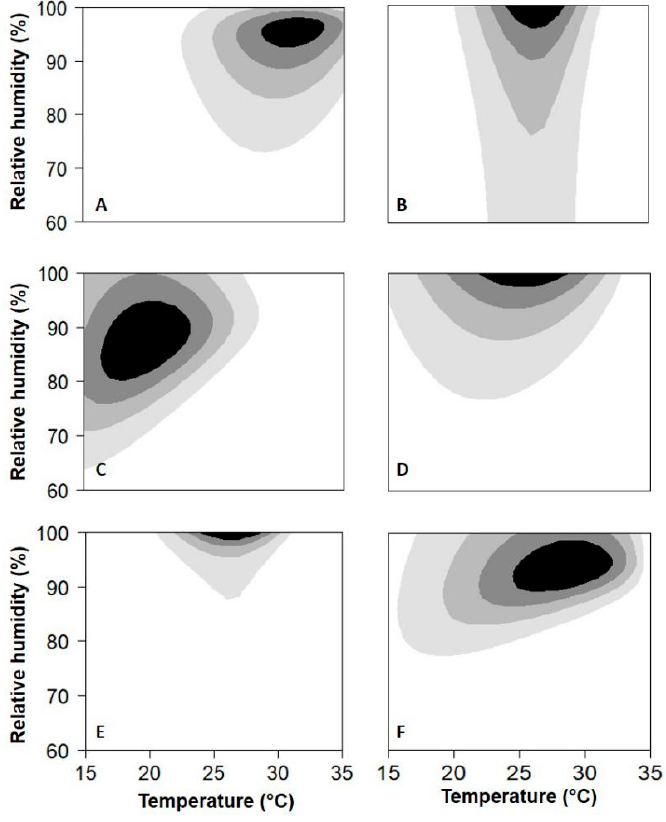
Figure 4. Relative colonization of bunch trash that was treated with one of six BCAs ( A : AMY; B : BOT; C : NOL; D : SER; E : TAE; F : VIN, see Table 1) and that was then incubated at different temperatures (T) and with different relative humidity (RH) levels. The contour plots, which were generated with Equations (1) and (3), and the parameters listed in Table 2, identify five areas of relative colonization of bunch trash by the six BCAs: L (low, 0 to 0.2 relative colonization; the white area); ML (medium-low, 0.2 to 0.4; the light grey area); M (medium, 0.4 to 0.6; the medium grey area); MH (medium-high, 0.6 to 0.8; the dark grey area); and H (high: 0.8 to 1; the black